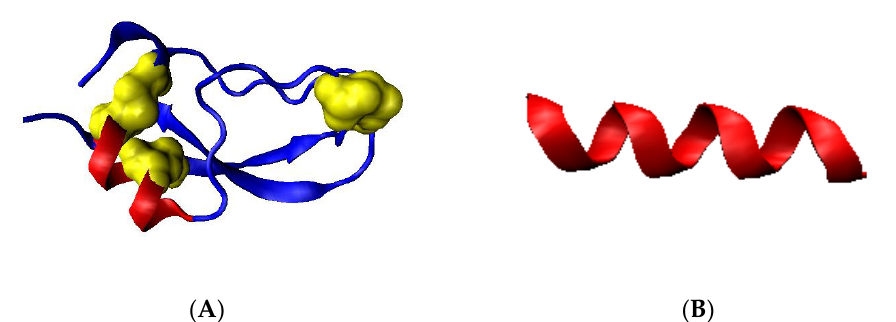
Figure 1. Presentation of 3D structures. ( A ) — the BPTI protein with highlighted helical section (red) and disulfide bonds (yellow) — PDB ID 4PTI. ( B ) — the chain of polyalanine (13 amino acids) in α - helical form.